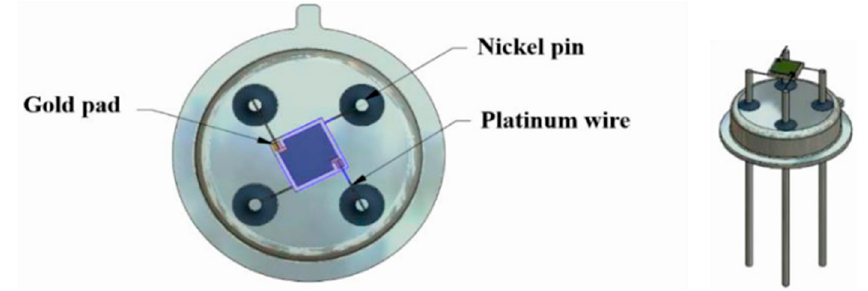
Figure 2. Substrate construction and photo of final device.